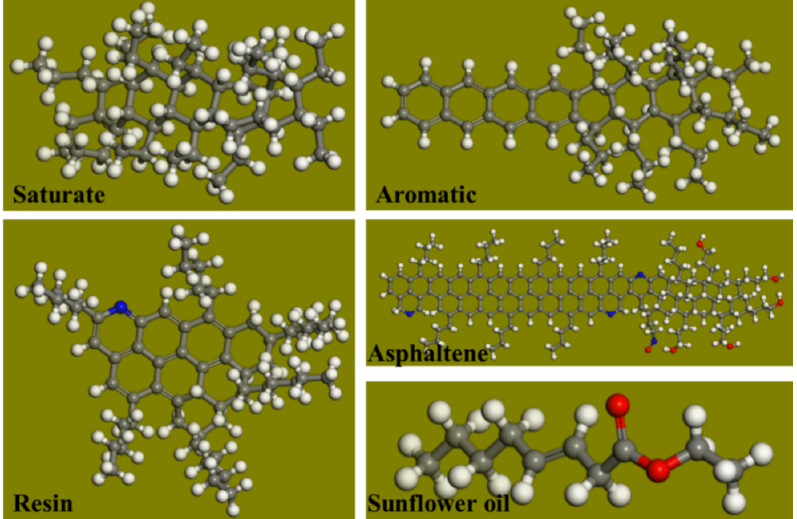
Figure 14. The molecular models of saturates, aromatics, resins, asphaltenes, and sunflower oil.